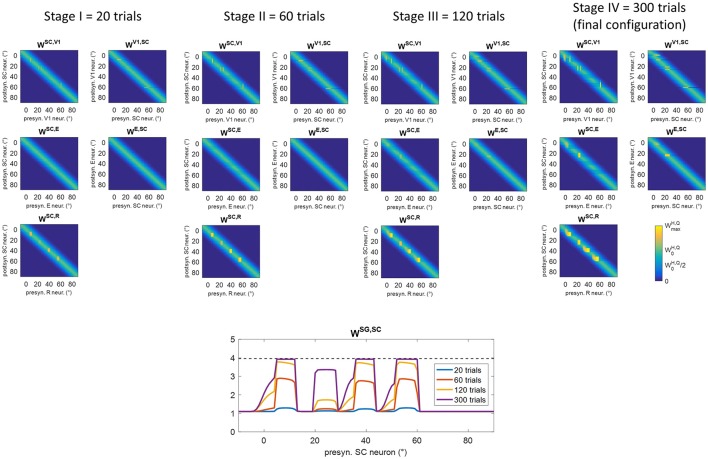
Pattern of inter-area synapses for patient #9 at four different stages of training A (after 20 training trials, 60 training trials, 120 training trials, 300 training trials corresponding to the end of training). At each stage, the four positions (8°, 24°, 40°, 56°) had received the same number of stimulations. For sake of space, only the most significant synapses are reported including synapses from the retina to SC (WSC, R), reciprocal synapses between SC and cortical visual areas V1 and E (WSC, V1, WV1, SC, WSC, E, WE, SC) and synapses from SC to SG (WSG, SC, bottom plot). Each color map has the same meaning as in Figure 1B, where x-axis denotes the position (j) of the pre-synaptic neuron in area Q, y-axis denote the position (i) of the post-synaptic neuron in area H, and the color value at the intersection (j,i) indicates the strength of the synapse WijH,Q. In each color map, the color scale ranges between 0 and the maximum value WmaxH,Q (Table 1) for the represented synapses. W0H,Q is the central weight of the pre-training Gaussian pattern. The bottom plot, displaying synapses WSG, SC at different stages, reports the position (j) of the SC presynaptic neuron on the x-axis (in the range −10° to 90°) and the value of the corresponding synapse WjSG,SC on the y-axis. The dashed black line marks the value WmaxSG,SC. At the first stages of training (Stage I and II), synapses interconnecting active neurons around the stimulated positions start to reinforce. At the end of Stage II, synapses WSG, SC at the stimulated positions become strong enough to elicit an oculomotor response rightward (so that an activation wave moves leftward). Hence, synaptic reinforcement extends leftward (Stages III and IV) but only to a limited extent as gaze moves only by a few degrees before stimulus removal, i.e., before the end of the trial. At position 24°, leftward extension of synaptic reinforcement does not occur as the stimulus is perceived before oculomotor response is triggered. At this position also reciprocal synapses WSC, E and WE, SC reinforce too. Modifications of synapses WSC, V1, WV1, SC, WSC, E, WE, SCaround 0° (see Stage IV) arise from the activation produced in these areas when the stimulus reaches the fovea and the intact side.